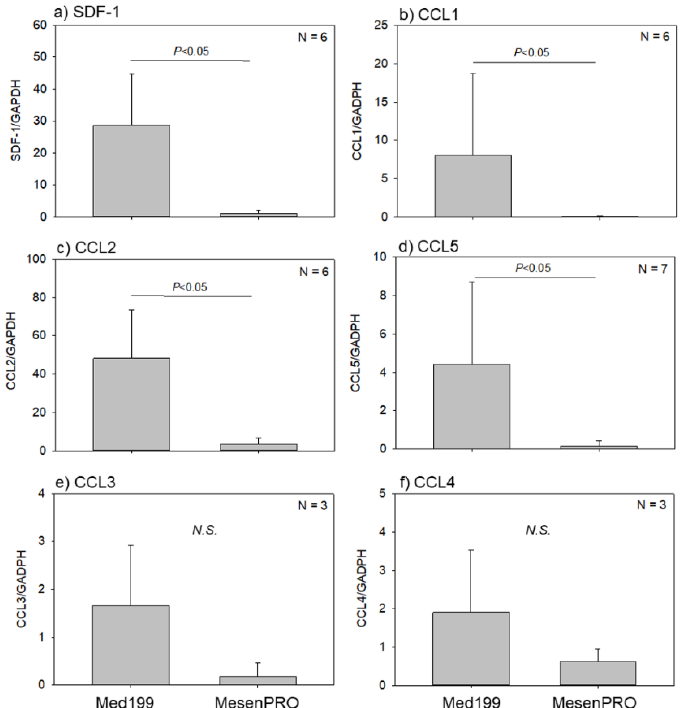
Figure 3. Effects of culture media on mRNA expression levels of chemotactic factors, ( a ) stromal cell derived factor-1 (SDF-1), ( b ) chemokine C-C motif ligand (CCL1), ( c ) CCL2, ( d ) CCL5, ( e ) CCL3, and ( f ) CCL4, in tissue-engineered periosteal sheets (TPSs) in vitro. N.S. : not significant.